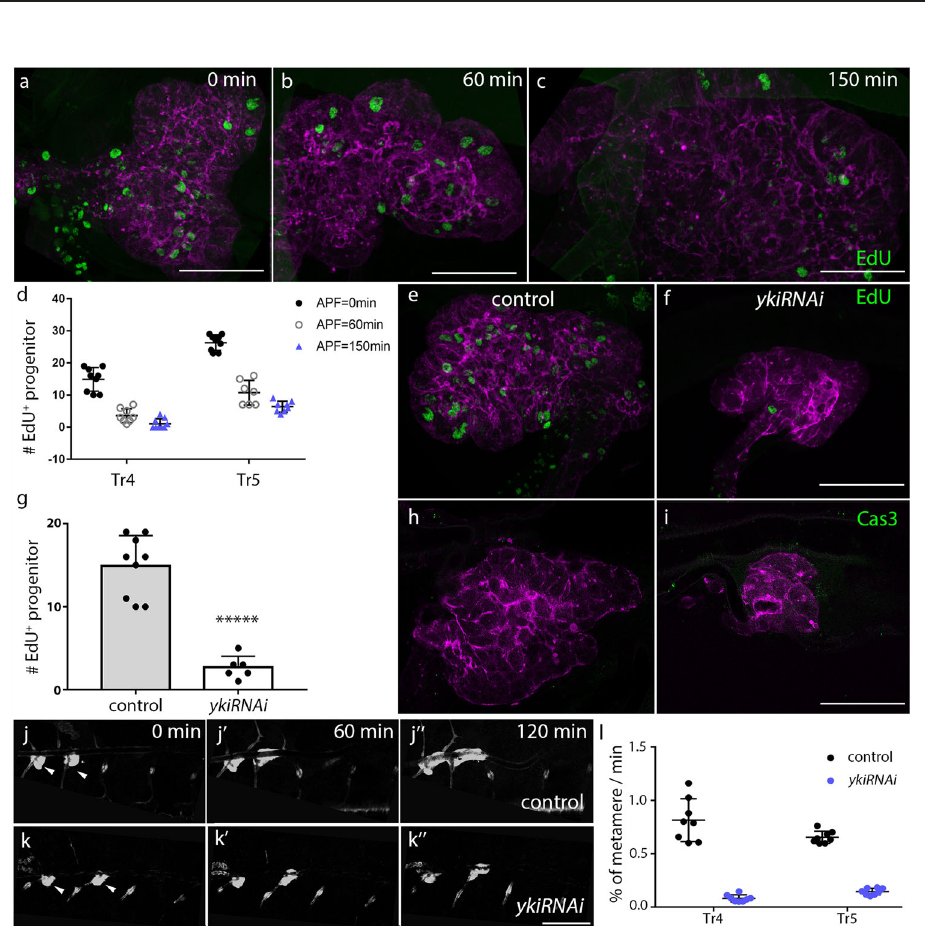
Fig. 2 The activities of insulin pathway and Hippo pathway in larval – pupal transition and starvation conditions. a Volcano plot of RNA-seq showing the comparison of gene expression pro fi les of tracheal progenitors in L3 larvae and white pupae during larval – pupal transition. b GO analysis reveals top functional clusters among the differentially expressed genes. c Heatmap showing the differential expression of genes in pupae relative to L3 larvae. d Volcano plot of RNA-seq showing differentially regulated genes in tracheal progenitors by starvation. e GO analysis reveals top functional clusters among the differentially expressed genes. f Heatmap showing the differential expression of genes by starvation. g Venn plot of differentially expressed genes (DEGs) in tracheal progenitors from starved L3 larvae and 0 h APF white pupae, compared to control L3 larvae. h – m ” Dynamic activation of reporters in L3 larvae ( h , i , j , k , l , m ), 0 h APF pupae ( h ’ , i ’ , j ’ , k ’ , l ’ , m ’ ) and L3 larvae post-starvation ( h ” , i ” , j ” , k ” , l ” , m ” ). h Four independent experiments were repeated with similar results. l – m ” , Staining tracheal progenitors of btl > GFP in L3 larvae ( l , m ), 0 h APF pupae ( l ’ , m ’ ) and L3 larvae post-starvation ( l ” , m ” ) with α - lacZ antibodies (magenta). m – m ” Merge images. n , o , Merge images showing lnR-SPARK droplets (arrowheads, green) and ex-lacZ (magenta) in L3 larvae (n) and white pupae ( o ). Scale bars: 50 μ m ( h – o ). p Box plot represents the relative level of ex-lacZ normalized to GFP signal from btl > GFP . 0 h APF ( n = 10; p = 1.38e-4) and starvation ( n = 11; p = 9.07e-6). n = 15 control fl ies. Four biologically independent experiments were performed. q Box plot showing the relative signals of SPARK reporters. InR-SPARK ( p = 2.02e-9), AMPK-SPARK ( p = 9.38e-4) and Akt-SPARK ( p = 1.61e-3). n = 16, 12, 10, 6, 5, 4 from the left to the right. Three biologically independent experiments were performed. p , q Unpaired two-tailed t -test was used for all statistical analyses. Results are presented as median with minima and maxima. 25th – 75th percentile (box) and 5th ~ 95th (whiskers) are indicated in the box plots. No adjustments were made for multiple comparisons in this fi gure. Source data for ( p , q ) are provided as a Source Data fi le.